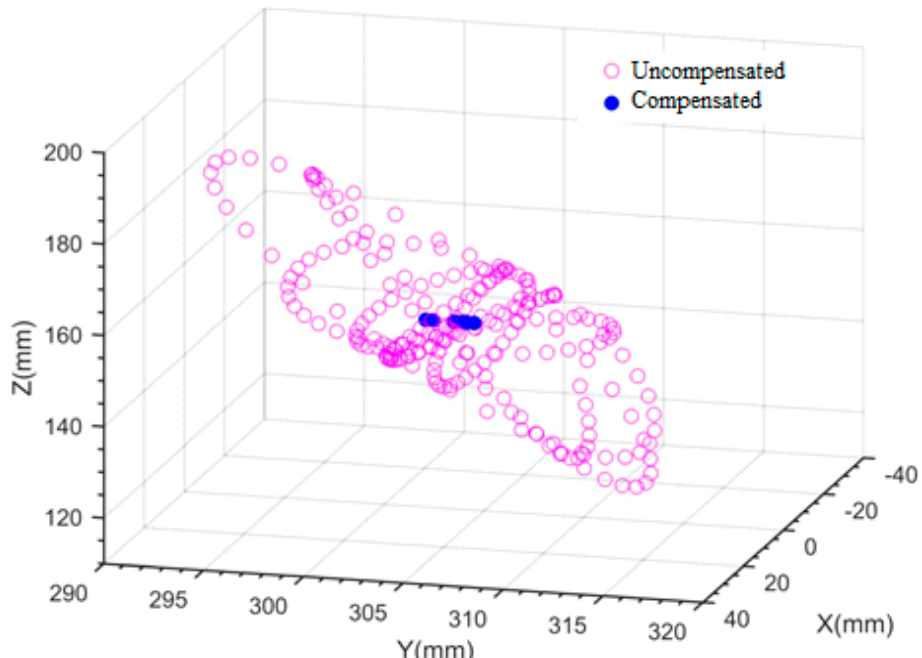
Figure 21. Comparison between uncompensated and compensated end effector trajectory when the ship is not equipped with an anti-rolling tank.